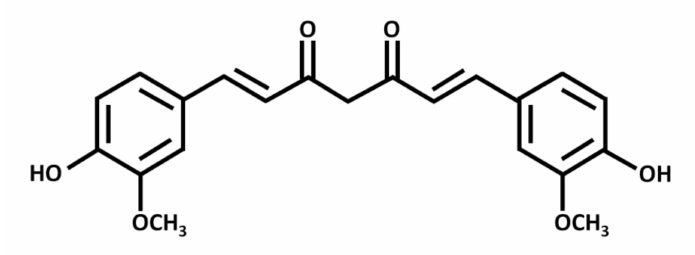
Figure 1. Chemical structure of curcumin, a polyphenolic chemical constituent of turmeric with antioxidant, anti-inflammatory, and anticancer e ff ects. Curcumin is a beta-diketone compound containing two substituted aromatic rings linked by a seven-carbon chain. Each aromatic ring has one hydroxy and one methoxy